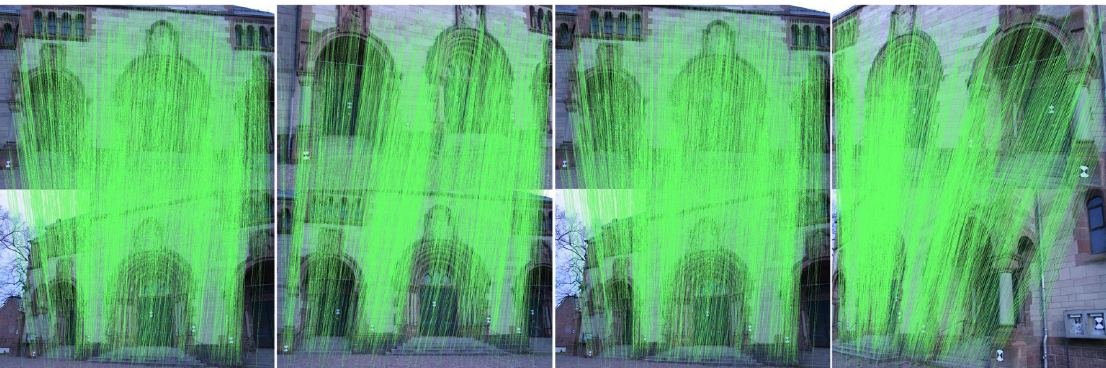
Figure 16. Feature correspondences of Herz-Jesu-P25 sequence in Strecha’s dataset. Note that these feature correspondences are very accurate. feature correspondences are very